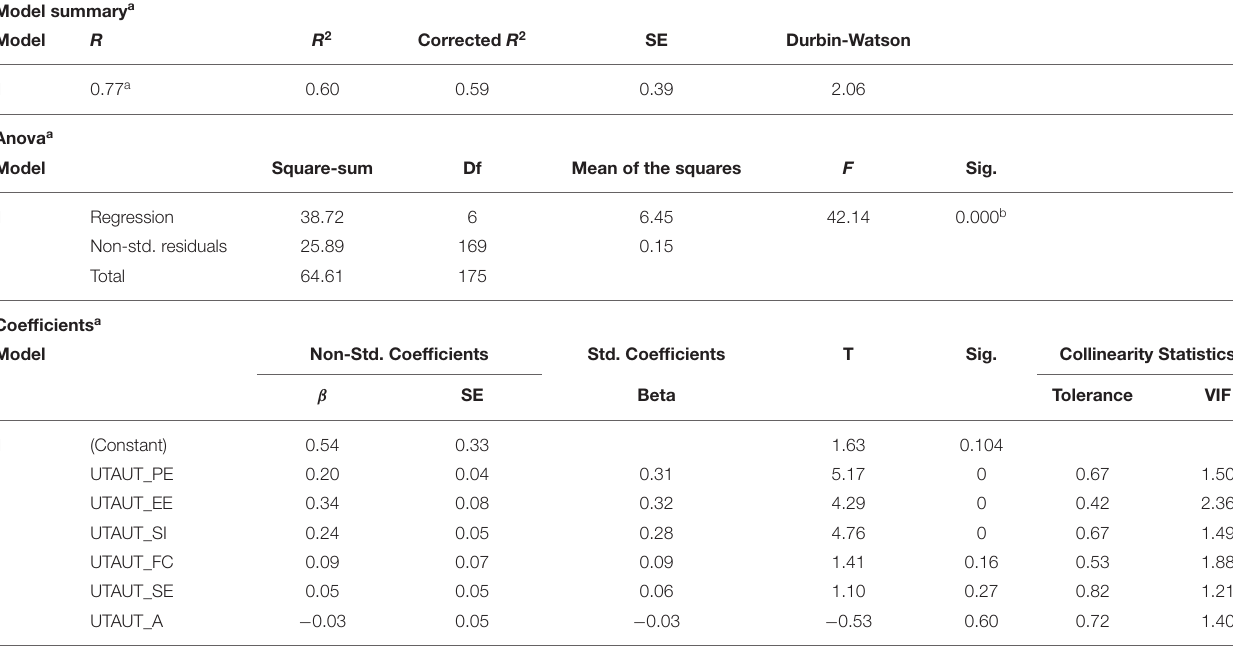
TABLE 4 | Influence of independent variables on attitude to use. Model summary